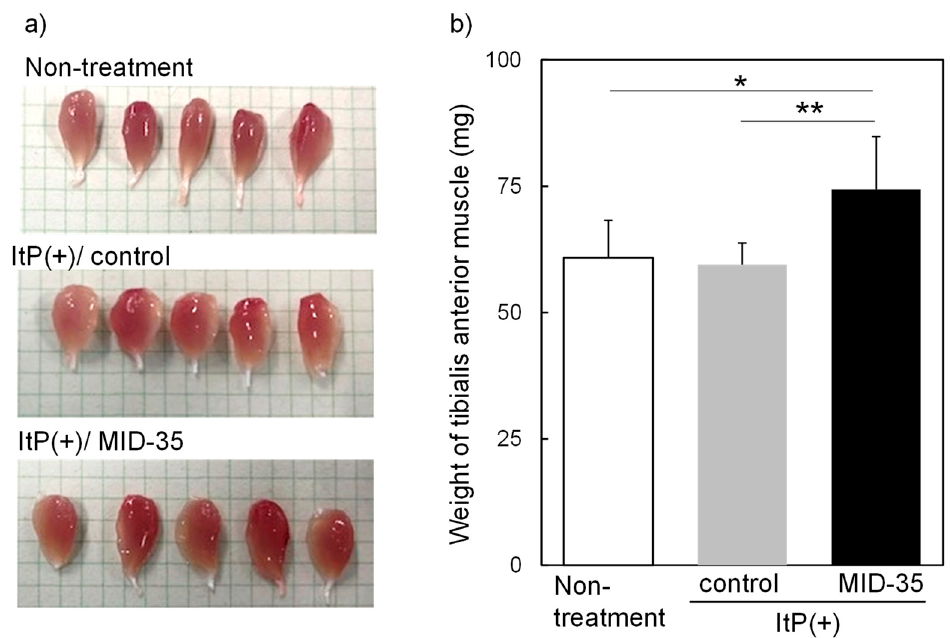
Figure 2. Effect of iontophoretic intramuscular delivery of MID-35 on ( a ) appearance and ( b ) weight of tibialis anterior muscle of mice: The tibialis anterior muscle was collected from mice hind legs on day 42 after performing ItP of MID-35 three times. Then, the weight of the muscle tissue was meas- ured. Quantitative data are presented as mean ± SD from at least three independent experiments. * p < 0.05, ** p < 0.01